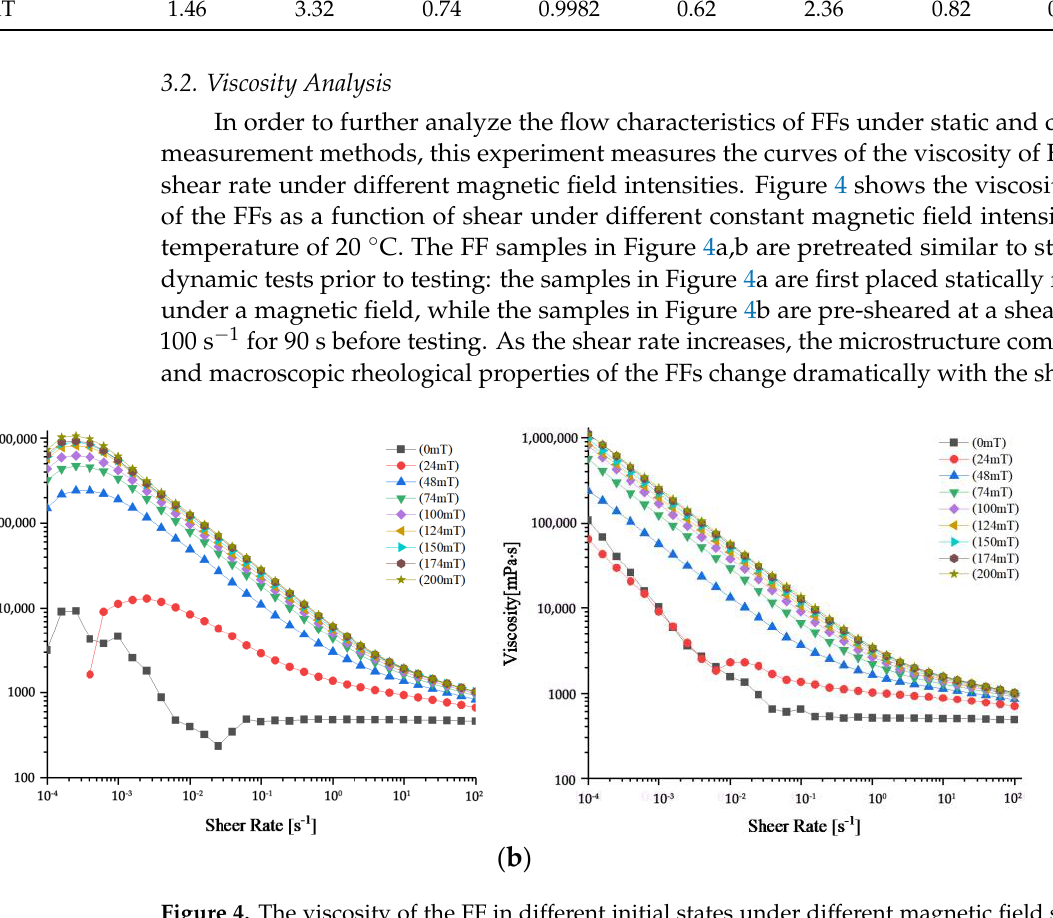
Fitting Parameter/M.F.